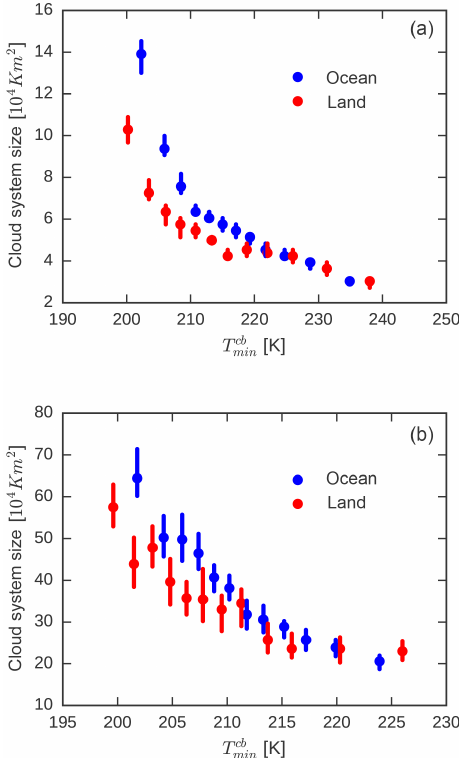
Figure 11. Median and standard error of horizontal extent versus minimum temperature within convective core for mature single- core (a) and multi-core (b) systems separately over land (red) and ocean (blue) (AIRS data,